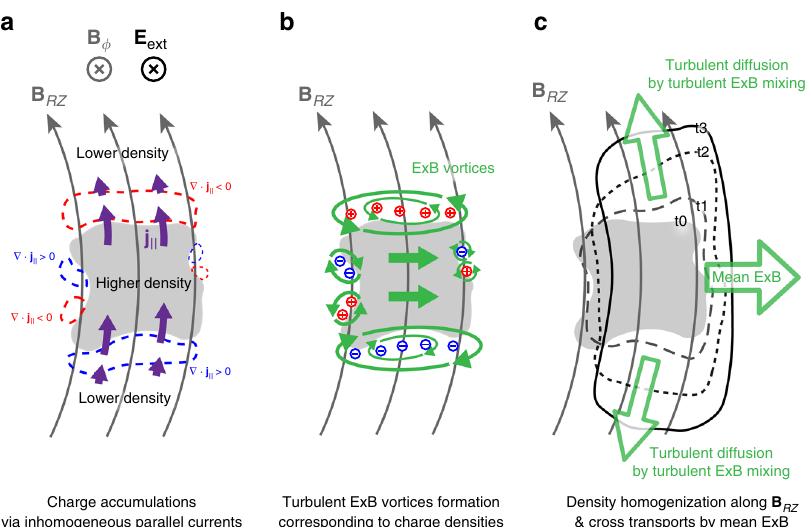
Fig. 7 Turbulent diffusion along B RZ by turbulent ExB mixing. a The space-charges ( ρ ) accumulate at the regions of high parallel density gradient ( ∇ k n e ) due to the inhomogenous parallel plasma currents (purple): ∂ ρ = ∂ t ¼ (cid:6) ∇ (cid:3) j k . Positive and negative charges accumulate at the convergent j k region (red dashed line) and the divergent j k region (blue dashed line), respectively. b Turbulent ExB vortices induced by the space-charges mix the inhomogeneous plasma density along their trajectories to yield homogeneity. c Repetitive charge accumulation and ExB mixing cause a turbulent diffusion along B RZ homogenizing the plasma density along B RZ . At the same time, the slower mean ExB moves the plasma across B RZ